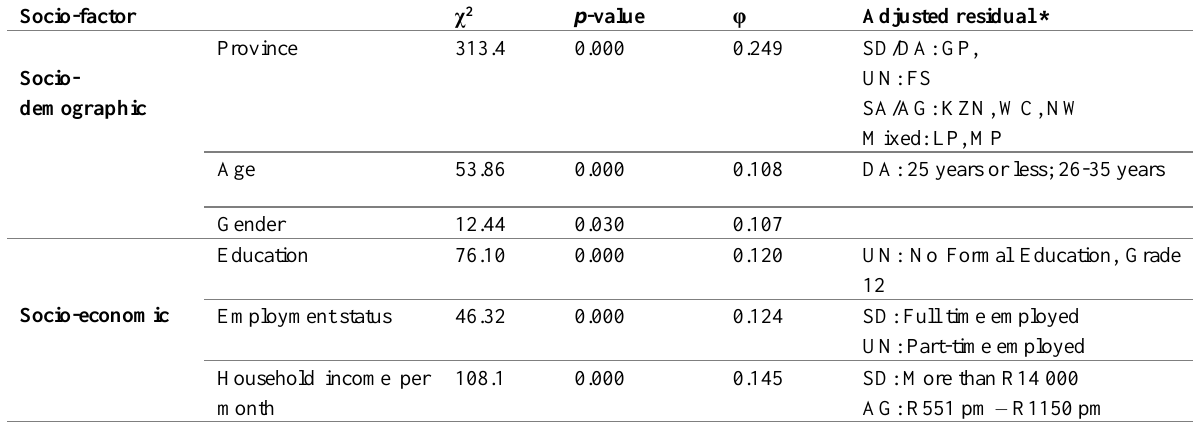
AG: R551 pm – R1150